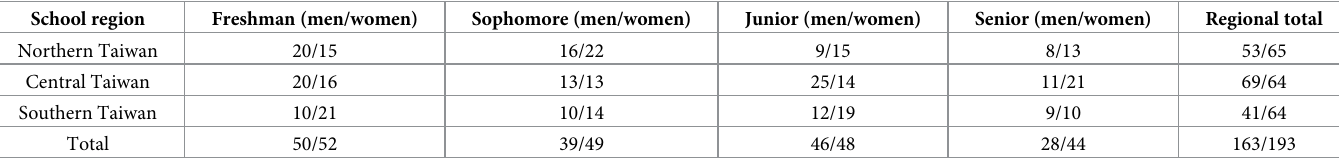
Table 1. Distribution of the